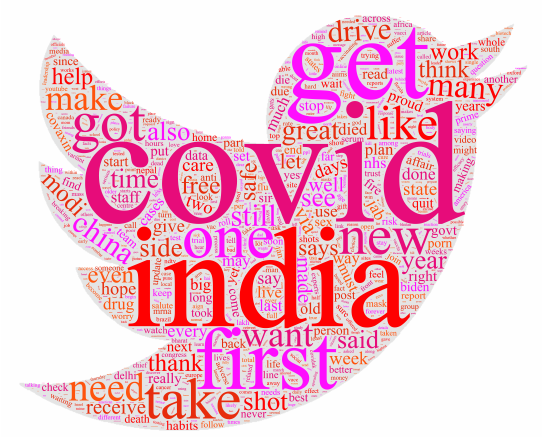
Figure 8. Wordcloud for the tweets dataset showing the most used